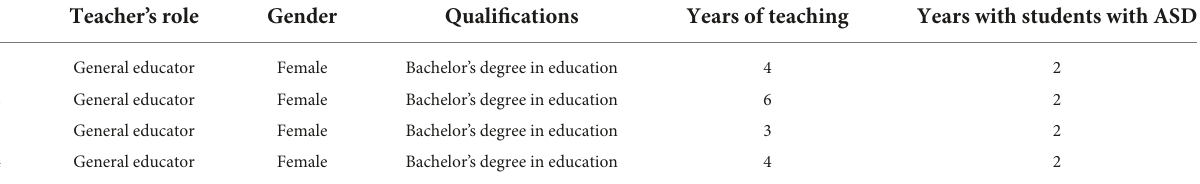
TABLE 1 Demographic data of the